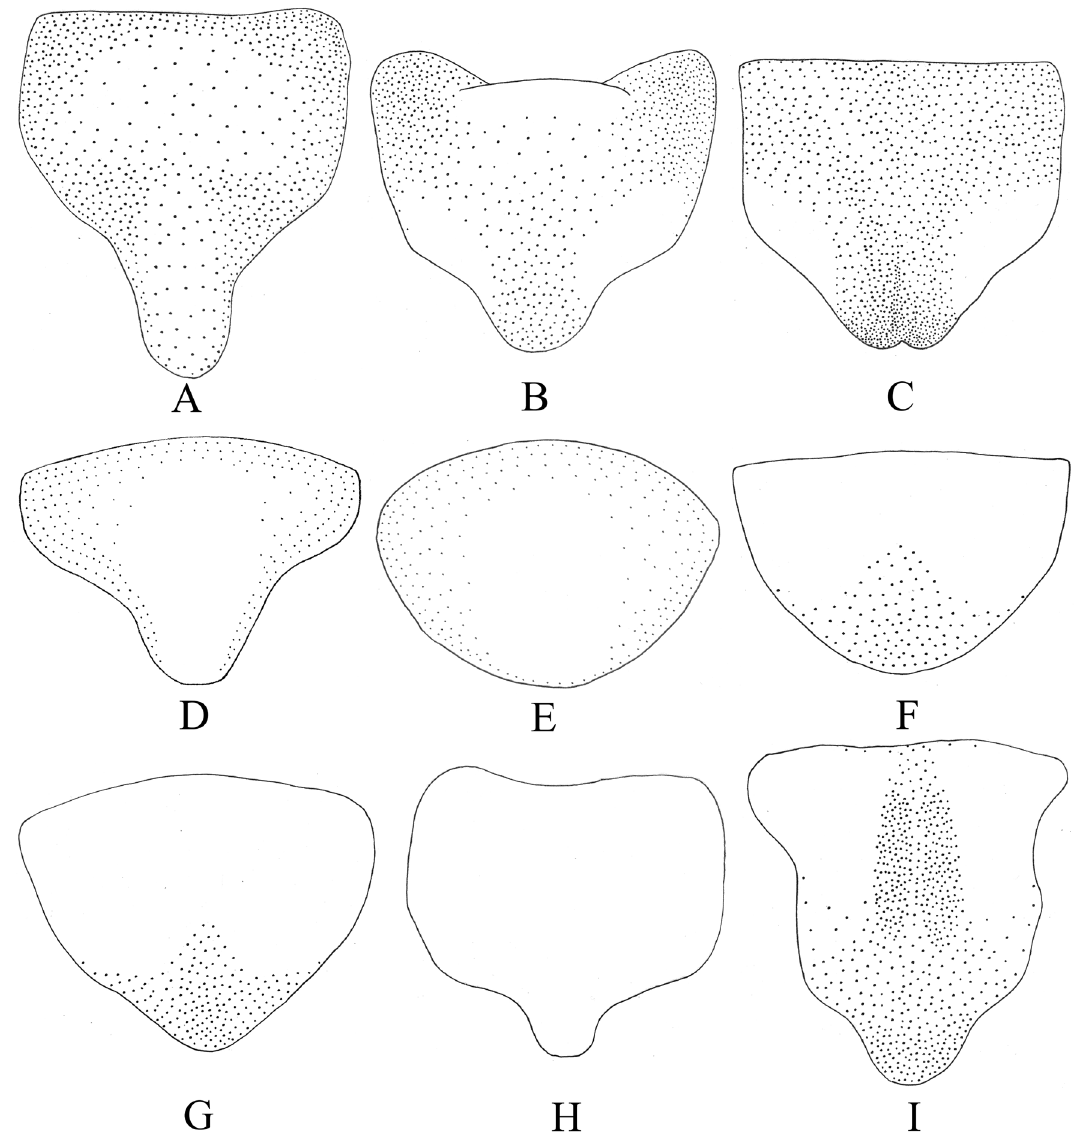
Figure 5. Female sternite VII: (A) Mitjaevia protuberanta . (B) Empoascanara sipra . (C) Empoascanara dwalata . (D) Cassianeura cassiae . (E) Cassianeura bimaculata . (F) Eupteryx minuscula . (G) Eupteryx gracilivramus . (H) Limassolla lingchuanensis . (I) Zyginella minuta